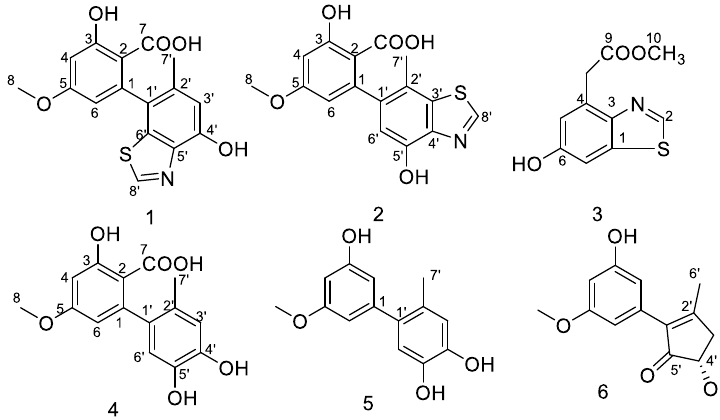
Figure 1. Structure of compounds 1 – 6 .